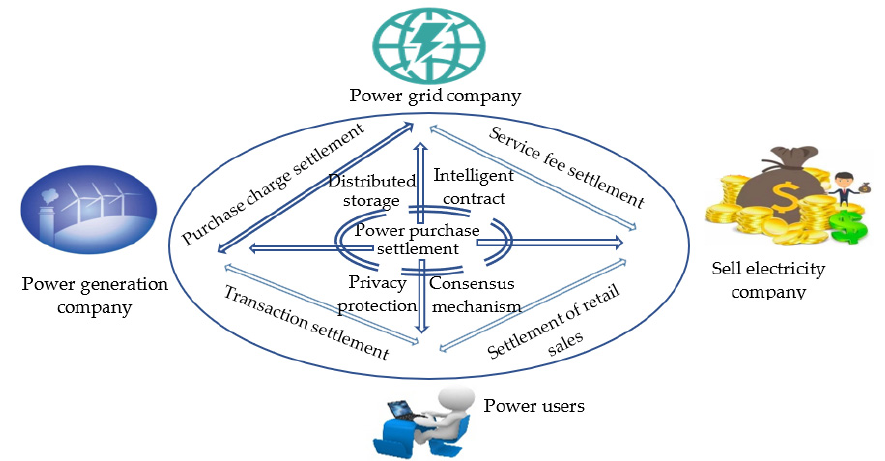
Figure 7. Application of the blockchain technology in electricity bill settlement.